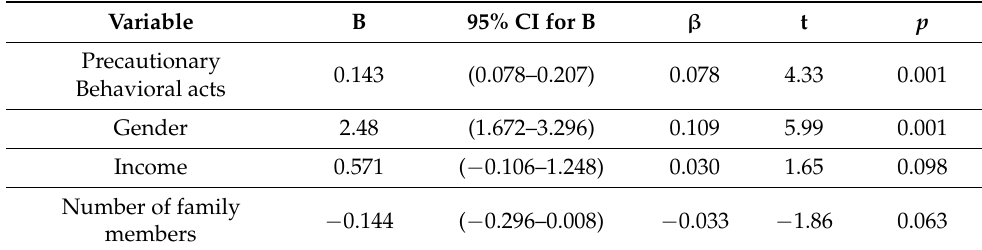
Table 5. Regression coefficients for predicting depressive